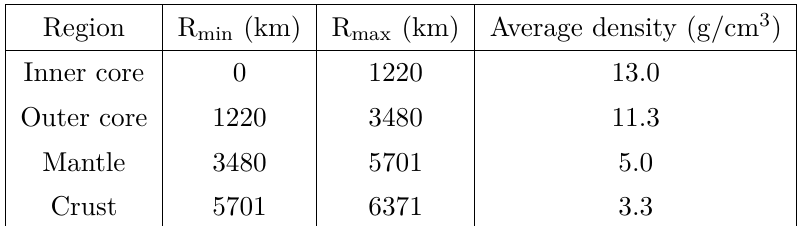
Table 3 . The radius and average density of each layer of the four-layered profile of Earth which preserves all the important features of Earth. R starts